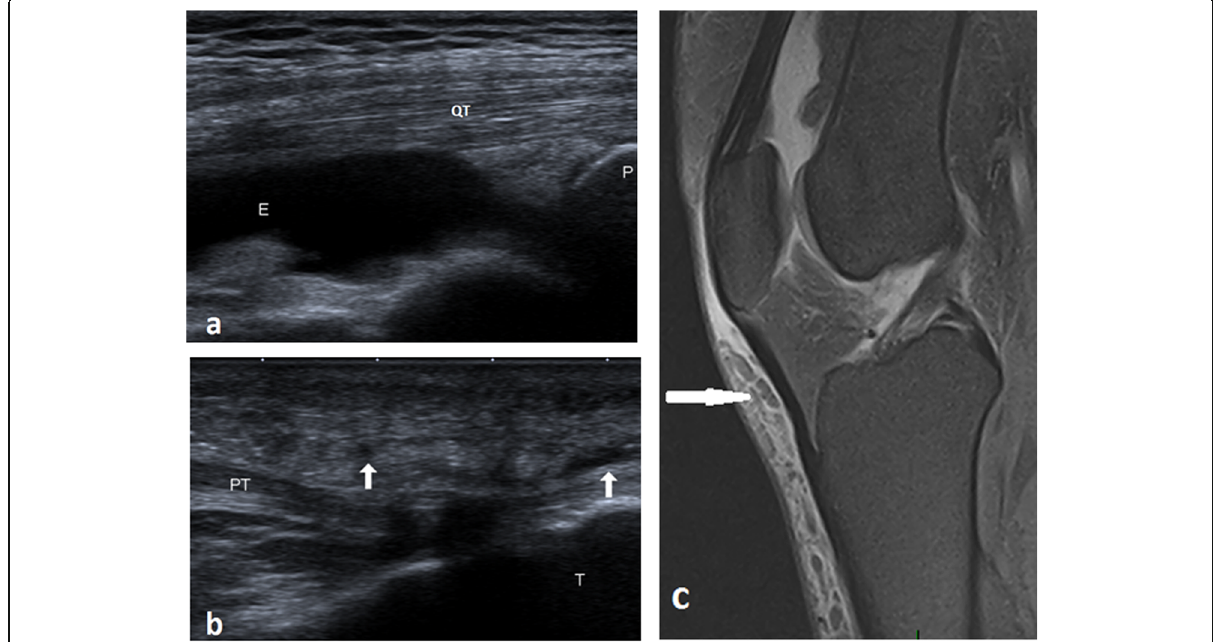
Fig. 5 A 44-year-old male with joint edema and anterior subcutaneous edema. a Long axis ultrasound image illustrates joint effusion in the suprapatellar pouch. b Long axis ultrasound scan illustrates hypoechoic subcutaneous reticulations anterior to the patellar tendon (arrows). c Sagittal PDFS MRI illustrates joint effusion, prepatellar, and superficial infrapatellar reticular fluid intensities of edema. QT, quadriceps tendon; PT, patellar tendon; E, effusion; P, patella; T,